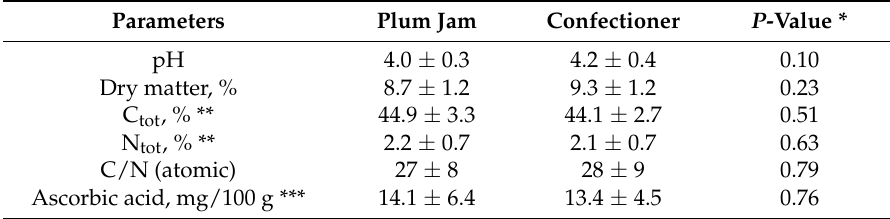
Table 4. Some chemical properties of husk tomato fruits as averaged over five experimental sites (mean ± standard